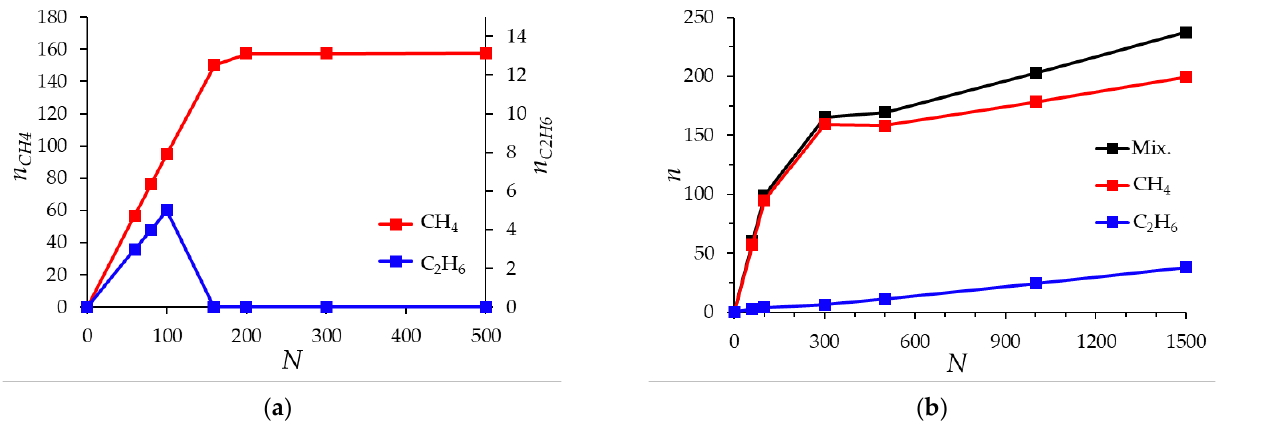
Figure 12. Dependence of the number of adsorbed molecules n of methane CH 4 and ethane C 2 H 6 and their total number (Mix.) on the number of molecules in the simulation cell N (ratio of the number of molecules of methane and ethane 95:5) for a pore with a width of 1.0 nm ( a ) and 1.8 nm ( b ). The temperature is 293 K.